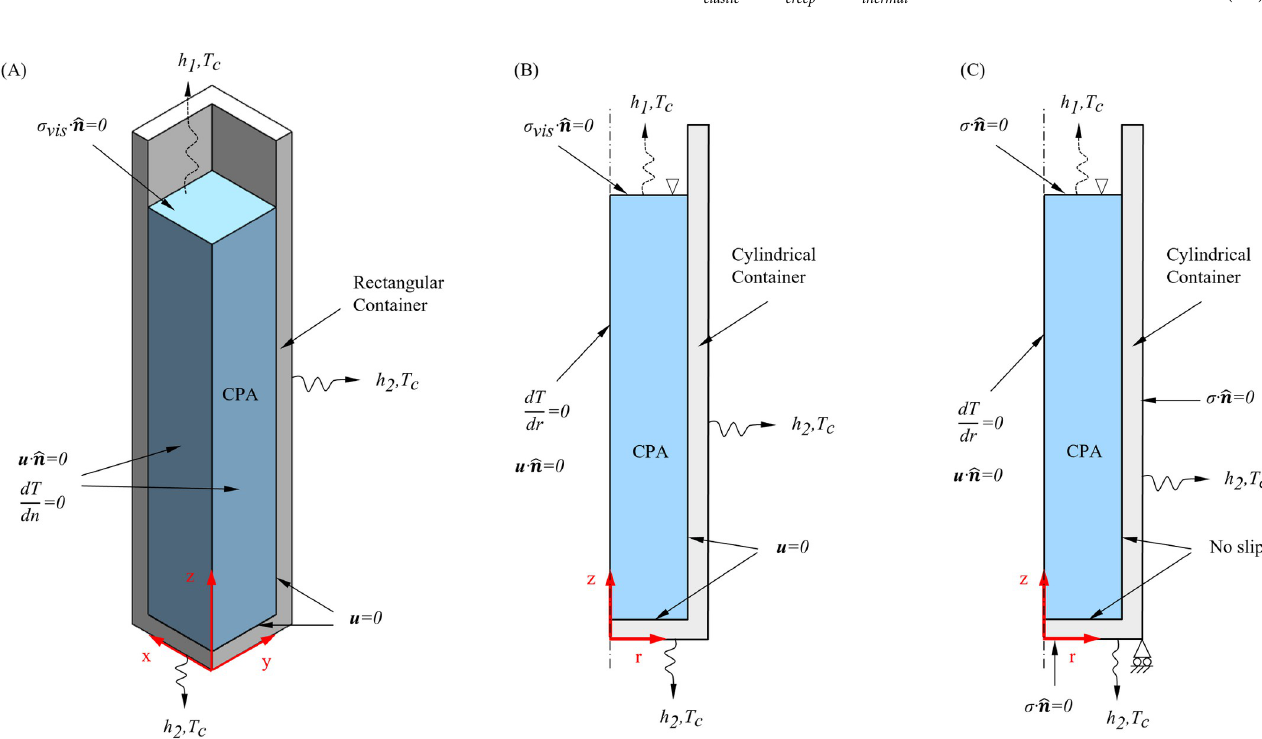
Fig 3. Schematic illustration of the geometric models and applied boundary conditions for FEA. (A) 3D geometric model and boundary conditions for the TF model; (B) 2D axisymmetric geometric model and boundary conditions for the TF model; (C) 2D axisymmetric geometric model and boundary conditions for the TM model; where σ vis denotes stress due to viscosity effects in the TF model.